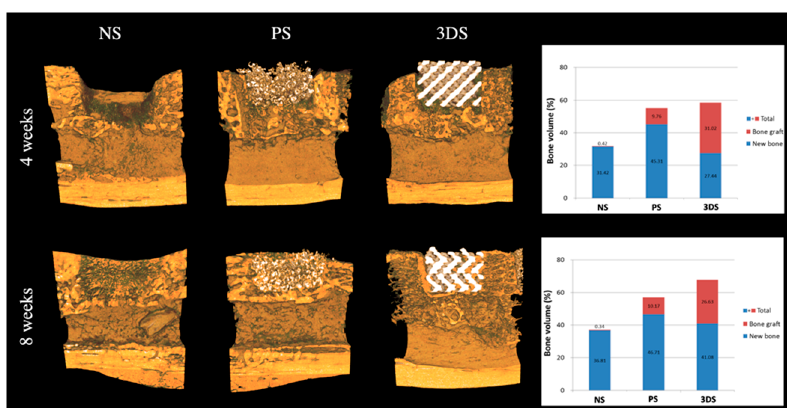
Figure 3. Radiological evaluation at 4 and 8 weeks.